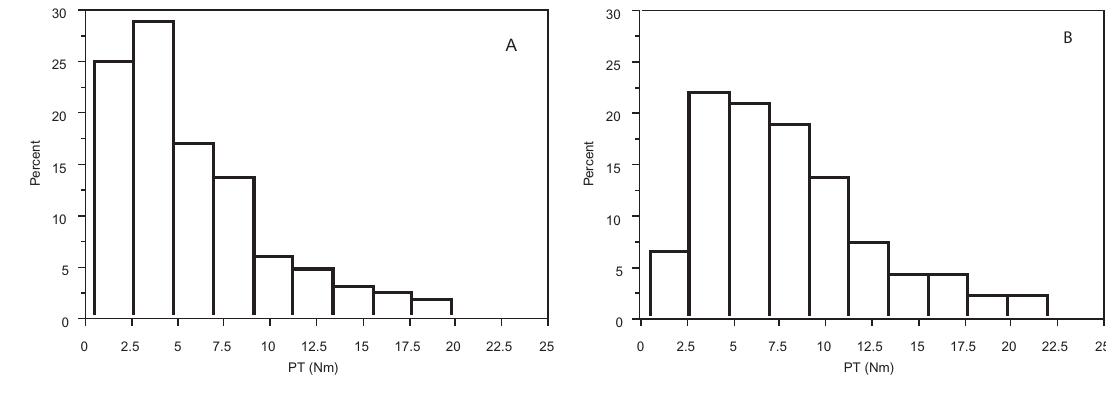
Frequency his- tograms of the elec- trically evoked peak torque (PT) values of the ankle dorsiflexor group in 20 critically ill patients (A) and 20 healthy controls (B). In the control pa- tients, there was a shift towards higher PT values: more than 50% of the PT values were >7.0 Newton- metre (Nm); In con- trast, more than 50% of PT values in the critically ill patients were ≤ 5.0